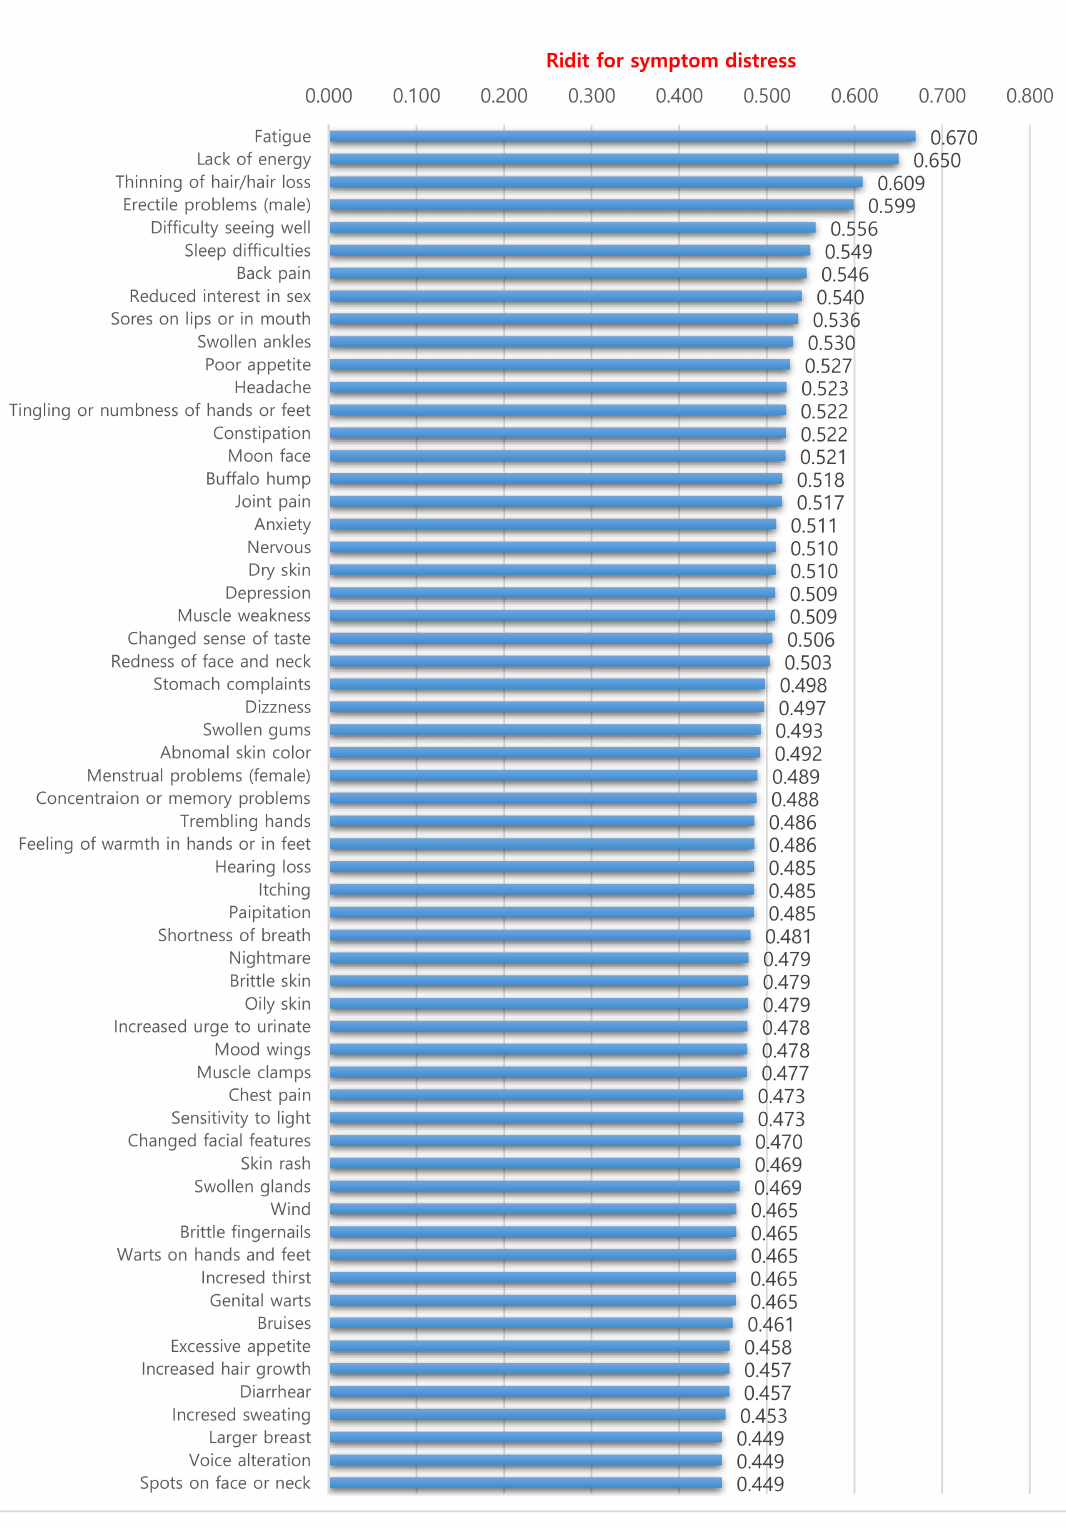
Figure 2. Distribution of symptom distress among all